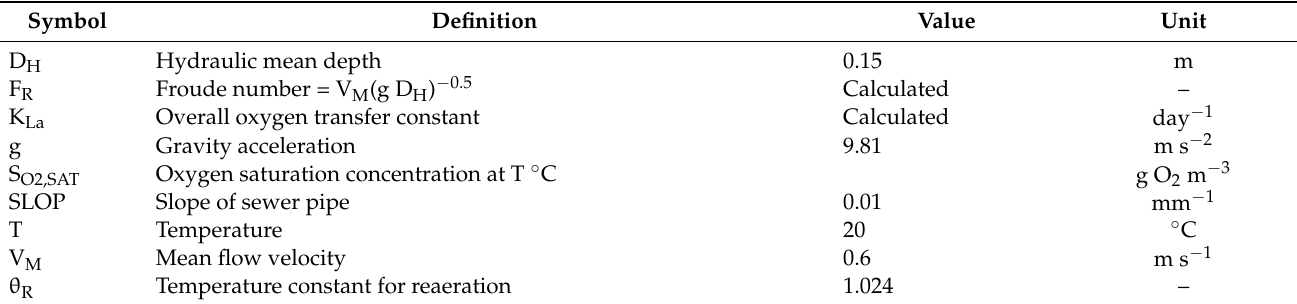
Table 5. Flow conditions and reaeration effect.